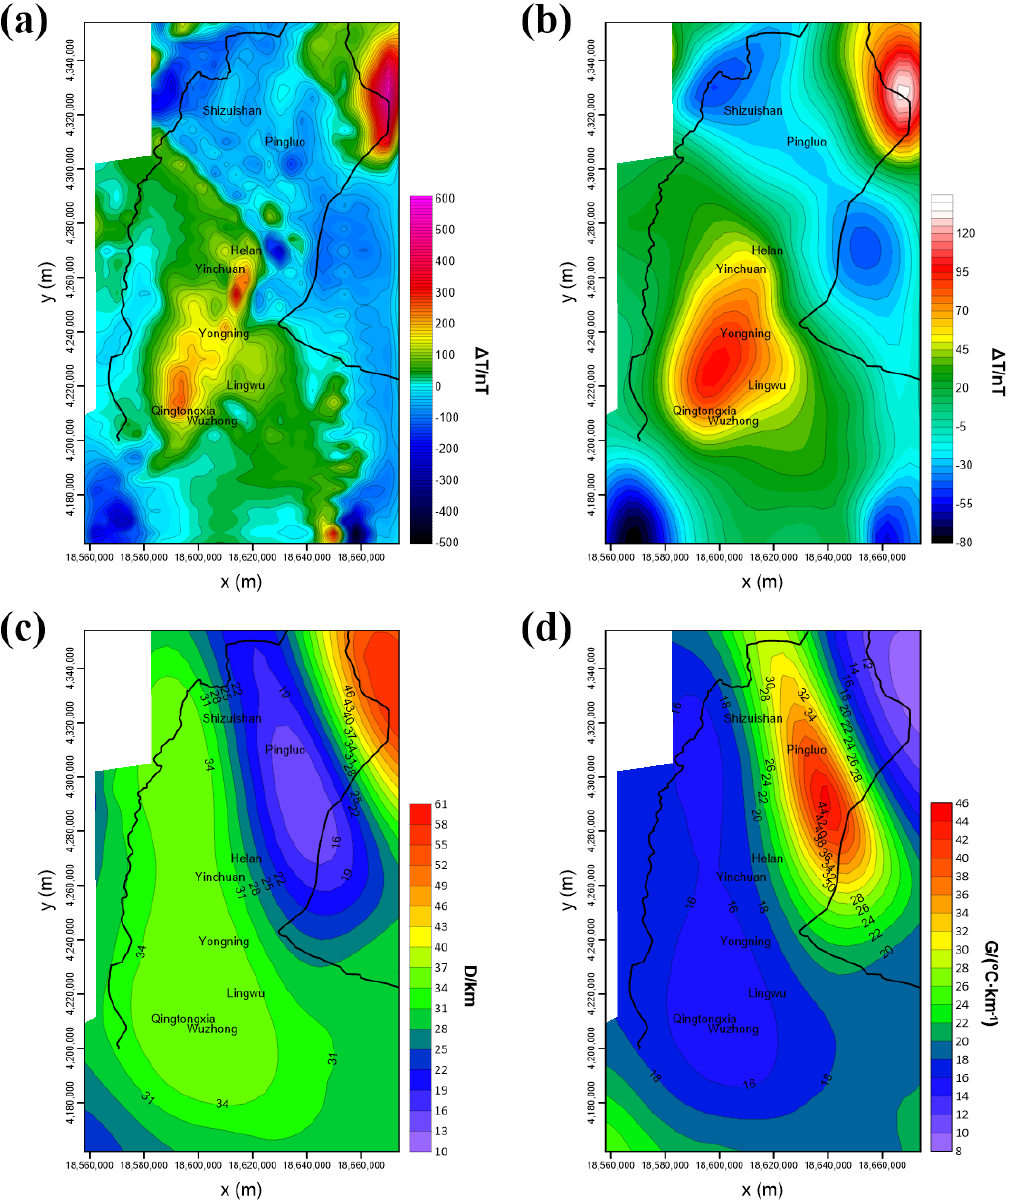
Figure 3. ( a ) pole magnetic anomaly; ( b ) upward continuation of 20 km from pole magnetic anomaly ( a ); ( c ) Curie depth map for Yinchuan Plain inverted from ( b ); ( d ) geothermal gradient inverted from ( b ).